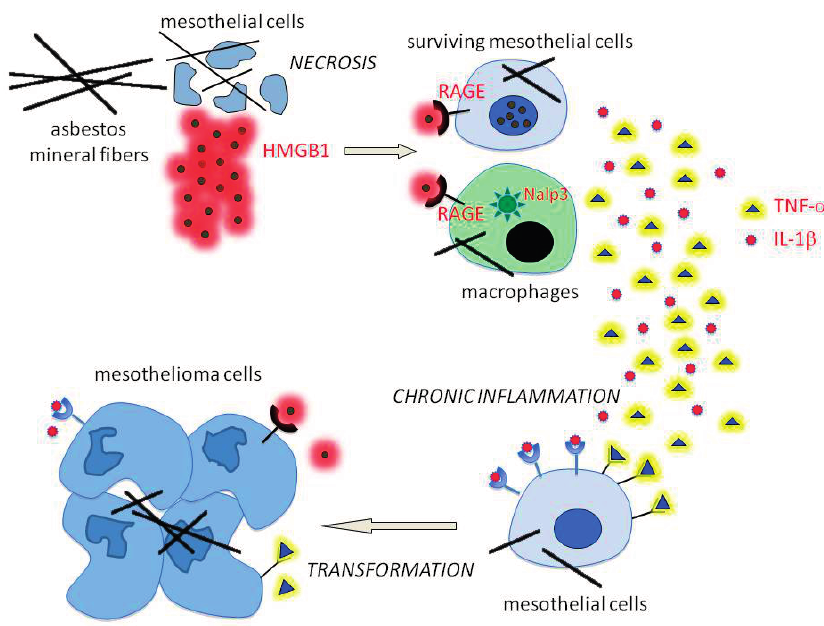
Figure 1. Asbestos and other mineral fibers cause necrotic death of mesothelial cells with the consequent release of HMGB1 in the microenvironment. HMGB1 binds to its receptor RAGE (Receptor for Advanced Glycation End products) of surviving mesothelial cells and macrophages, where it induces Nalp3 inflammasome. As a result, mesothelial cells and macrophages release pro-inflammatory cytokines including TNF- α and IL-1 β that cause chronic inflammation, followed by malignant transformation in presence of asbestos-induced DNA damage, and signaling dysregulation.